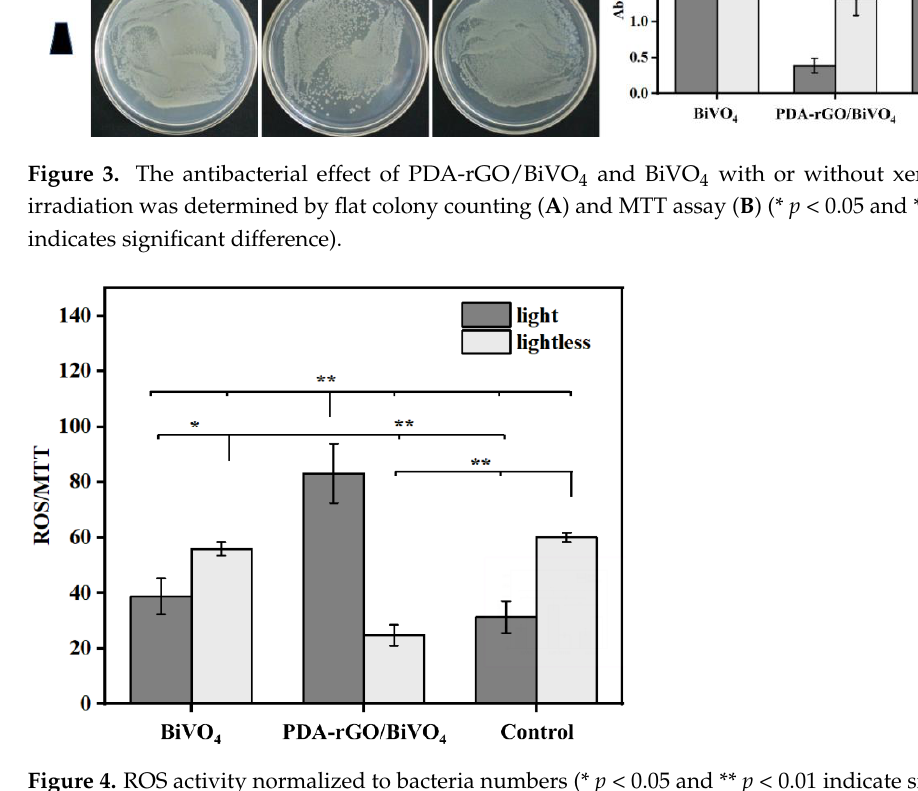
Figure 4. ROS activity normalized to bacteria numbers (* p < 0.05 and ** p < 0.01 indicate significant difference).